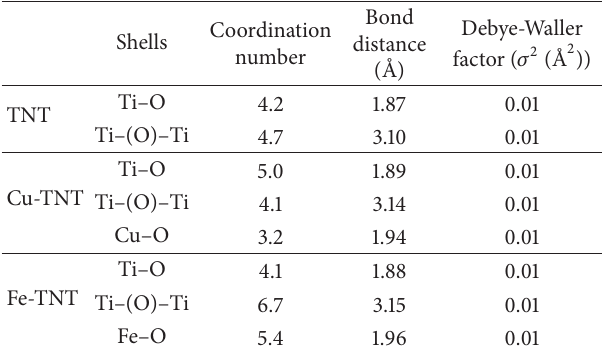
Figure 6: The Cu and Fe K-edges XANES spectra of the (a) Cu- TNT and (b) Fe-TNT, respectively. The empty and filled symbols represent the fitting and fractions of standards calculated by the linear combination algorithm. The experimental data are shown in solid lines. Table 1: Speciation data of the TNT, Cu-TNT, and Fe-TNT studied by